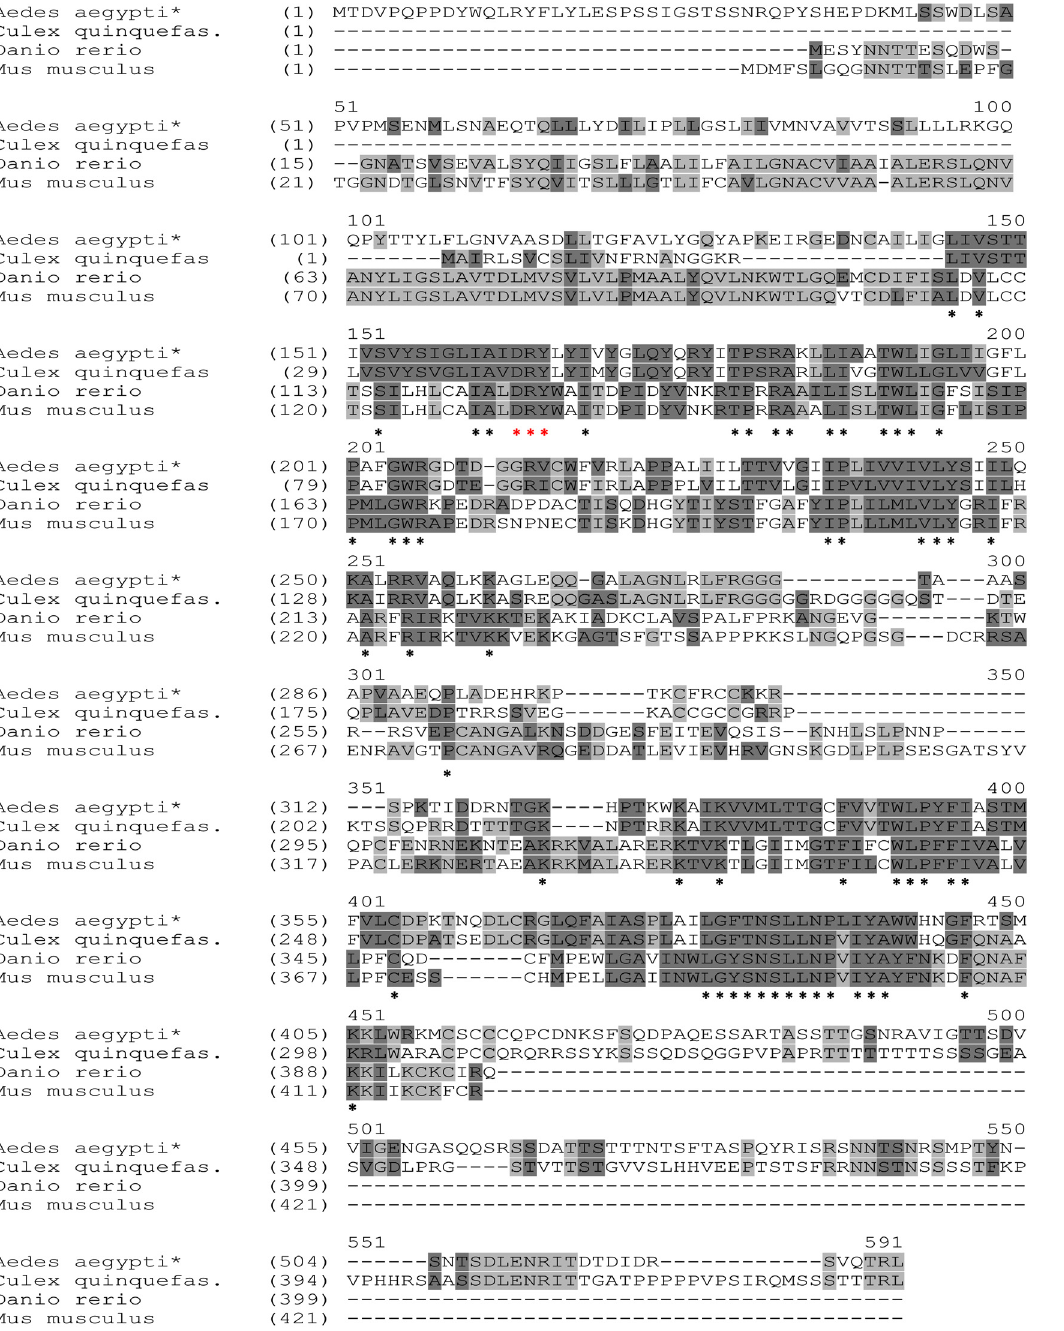
Fig 2. Alignment of AaSeR-1 ( Aedes aegypti ; AIK28864) with amino acid sequences of putative 5-HT receptors from: Culex quinquenfasciatus (mosquito; XP_001863625), Danio rerio (zebrafish; NP_001116793) and Mus musculus (house mouse; AAA81519). Conserved regions are marked with asterisks ( ‘ DRY ’ motif in